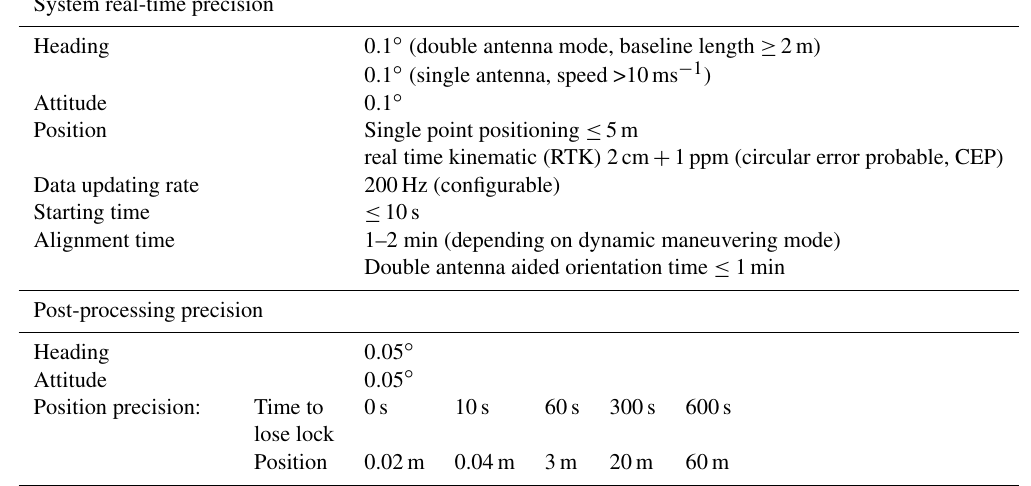
Table 2. Component parameters of the XW-GI5651 MEMS inertial–satellite integrated navigation system. System real-time precision